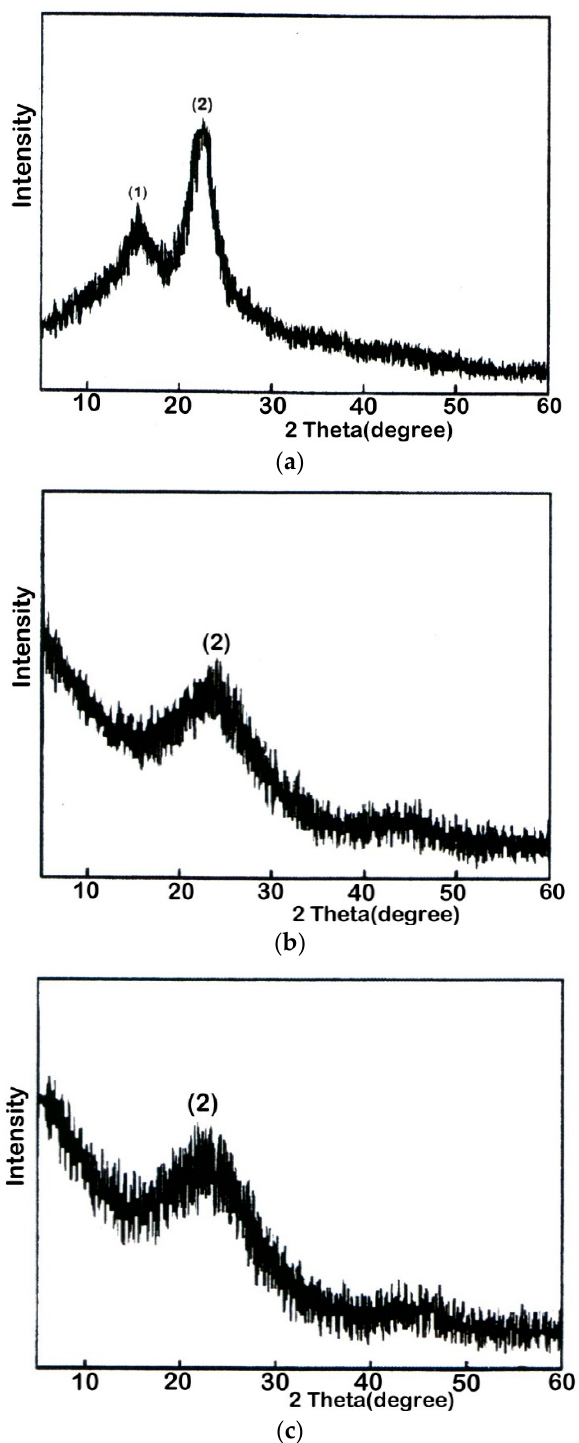
Figure 11. X-ray intensity curves: ( a ) WS w ; ( b ) CWS w and ( c ) CWS TD (slow heating rate; reactor pyrolysis temperature of 800 °C).